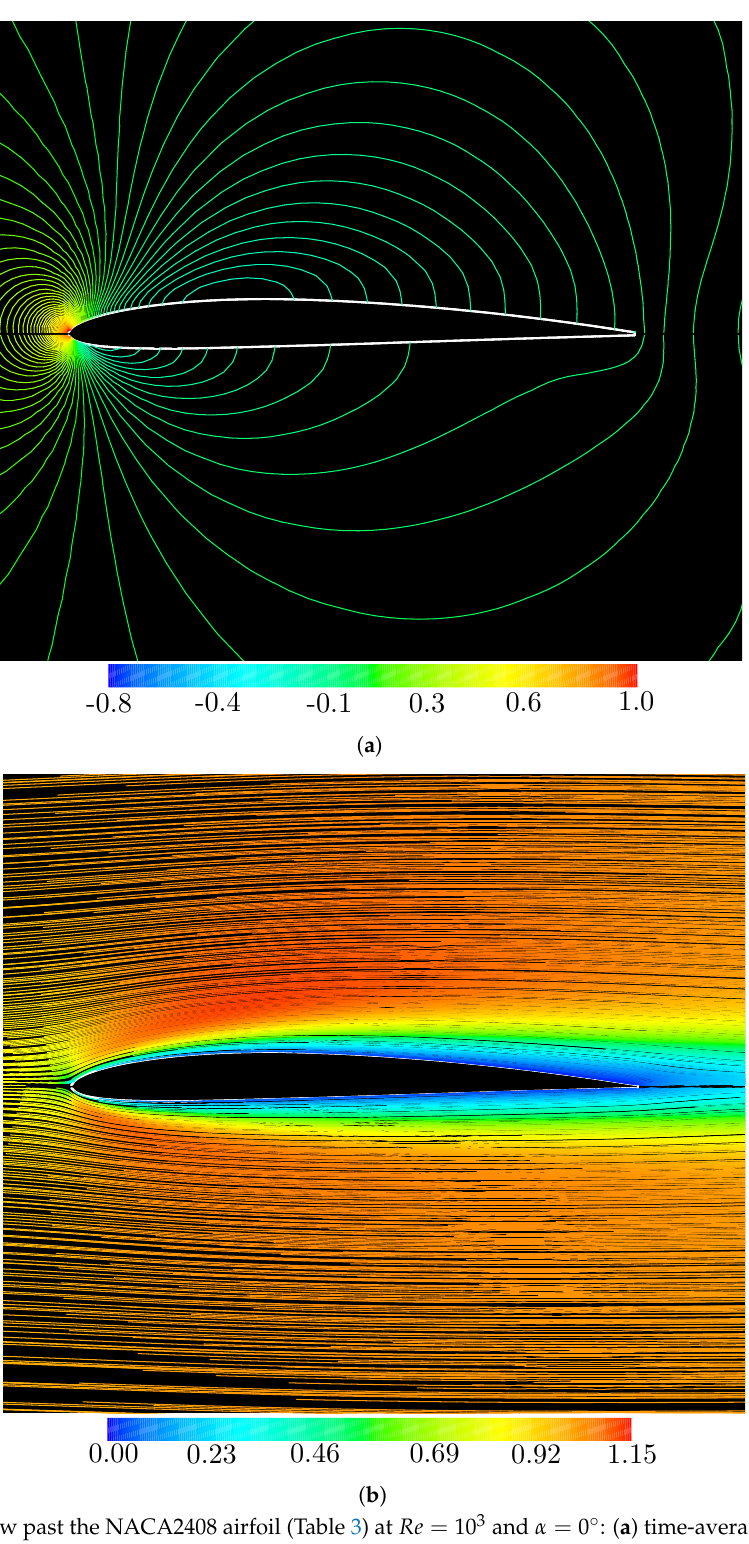
Figure 9. Flow past the NACA2408 airfoil (Table 3) at Re = 10 3 and α = 0 ◦ : ( a ) time-averaged pressure isolines; and ( b ) time-averaged